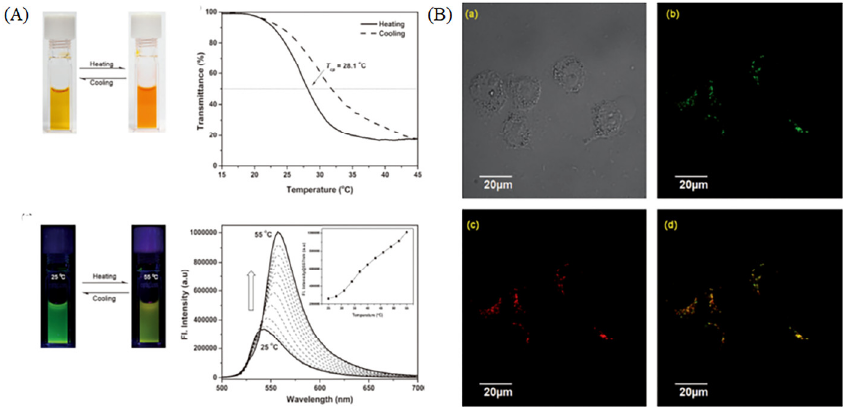
Figure 24. ( A ) Pictures and spectra of BDP-1 in diverse temperature solutions. ( B ) The staining operations and co-localization pictures of HeLa cells stained with BDP-1 and LTR (a commercial lyso- somal probe). DIC pictures ( a ) of HeLa cells; Confocal pictures of HeLa cells stained with BDP-1 ( b ) and LTR ( c ); ( d ) Merged pictures of ( b ) and ( c ). ( b ) Confocal pictures of BDP-1 Reproduced from [115] with permission of the Wiley, copyright 2014.